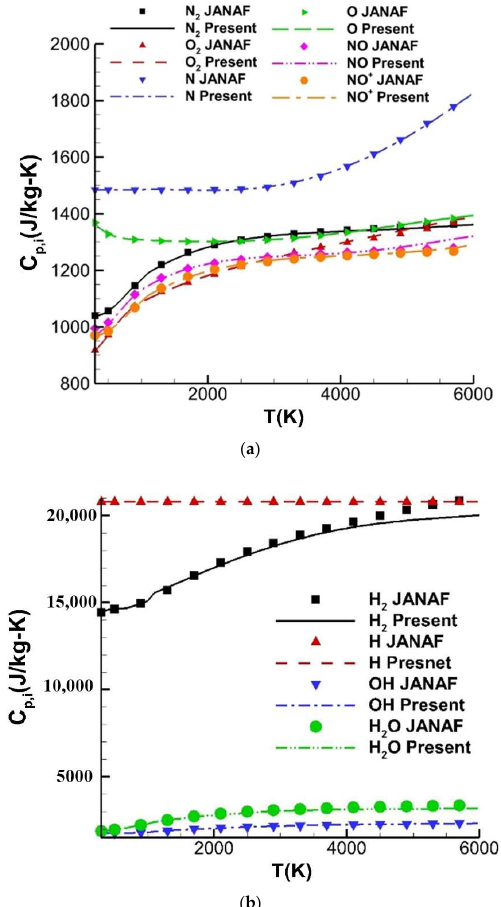
Figure 6. Comparison of specific heat at constant pressure of species. ( a ) Air species. ( b ) Hydrogenous species.